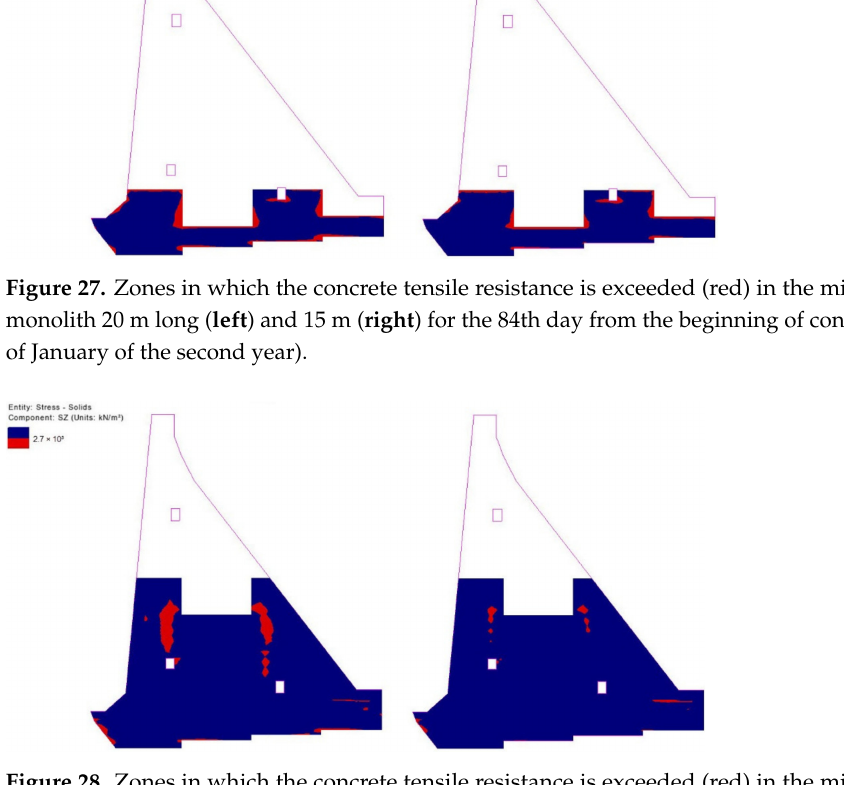
Figure 28. Zones in which the concrete tensile resistance is exceeded (red) in the mid-plane of the monolith 20 m long ( left ) and 15 m long ( right ) for the 283rd day from the beginning of construction (27th of July of the second year).